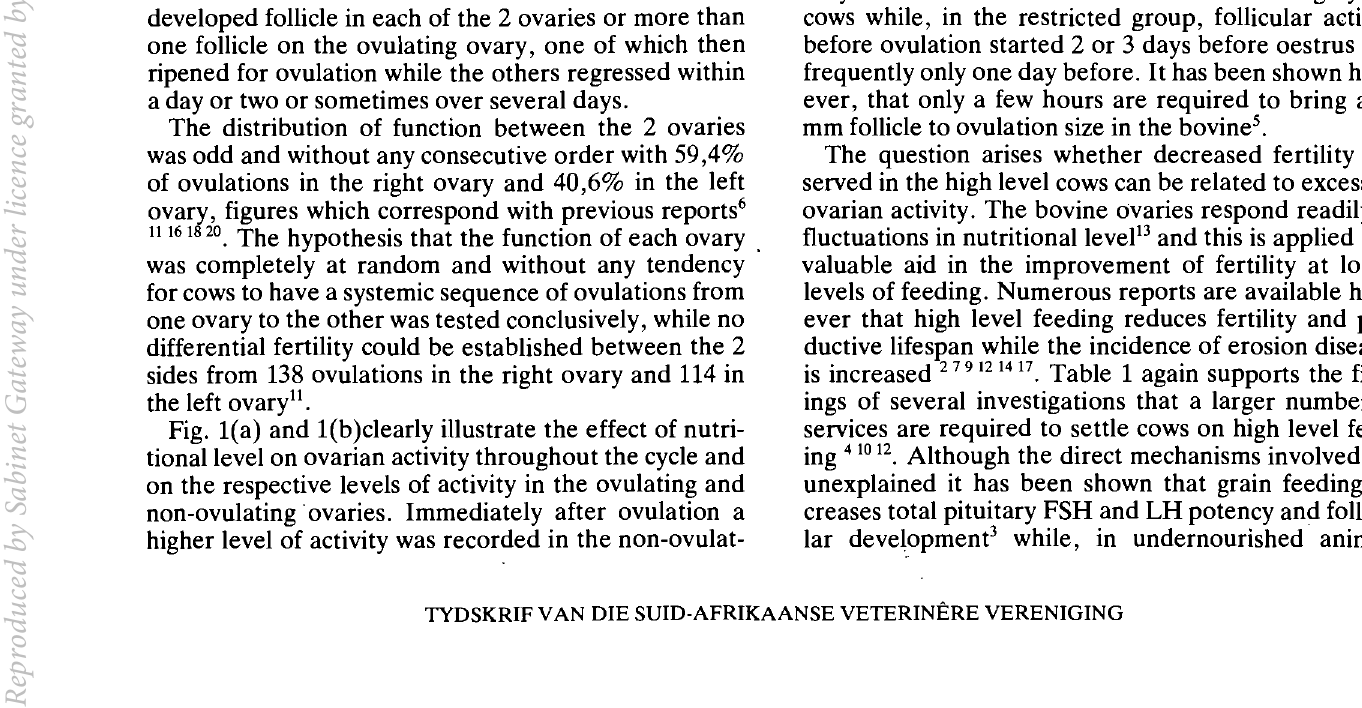
creased number of inseminations required per